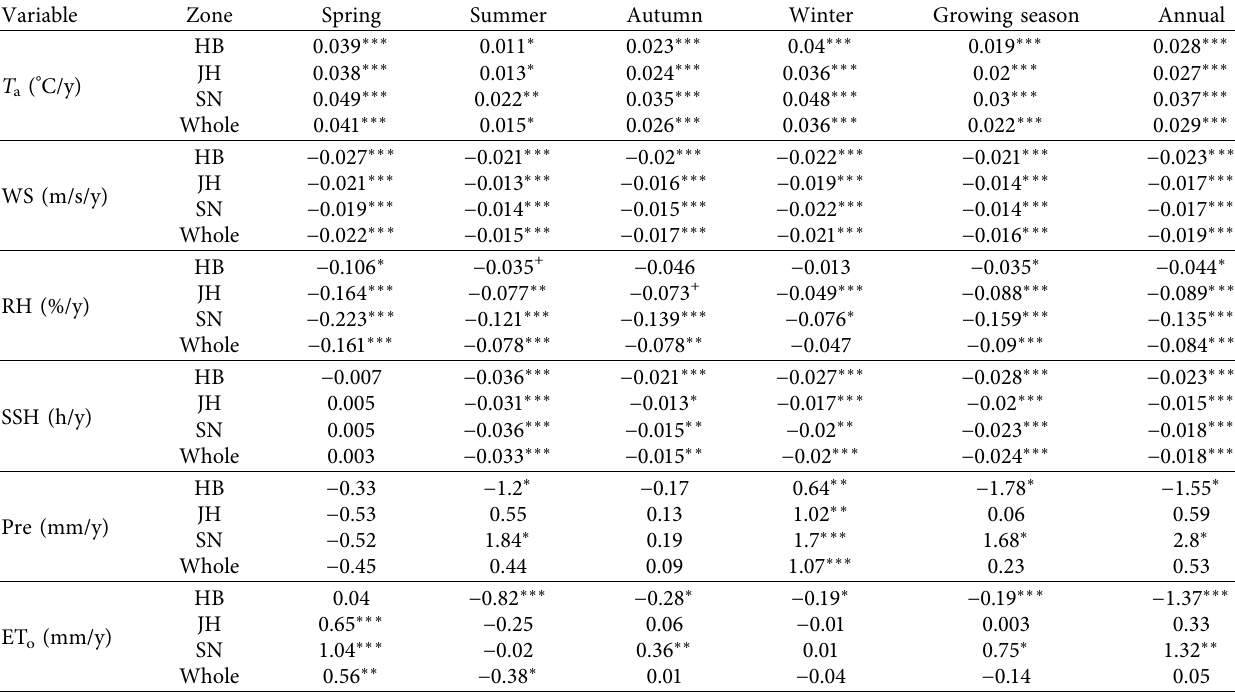
Table 1: Seasonal and annual trends of daily mean air temperature ( T a ), wind speed (WS), relative humidity (RH), sunshine hours (SSH), precipitation (Pre), and reference evaporation (ET o ) in Huaibei (HB), Jianghuai (JH), Sunan (SN), and the entire Jiangsu province during 1960–2019 using the Mann–Kendall and Theil–Sen estimator